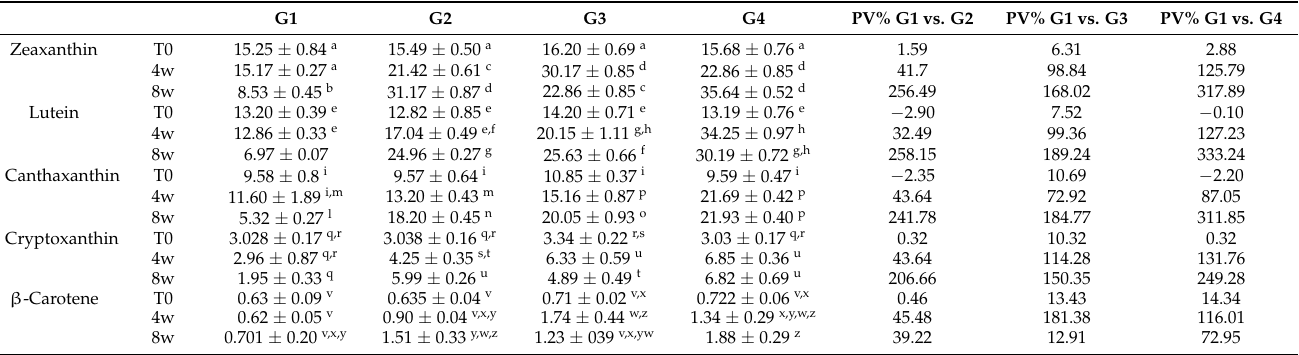
Table 2. Carotenoid composition of egg yolk of treated groups compared to the control.